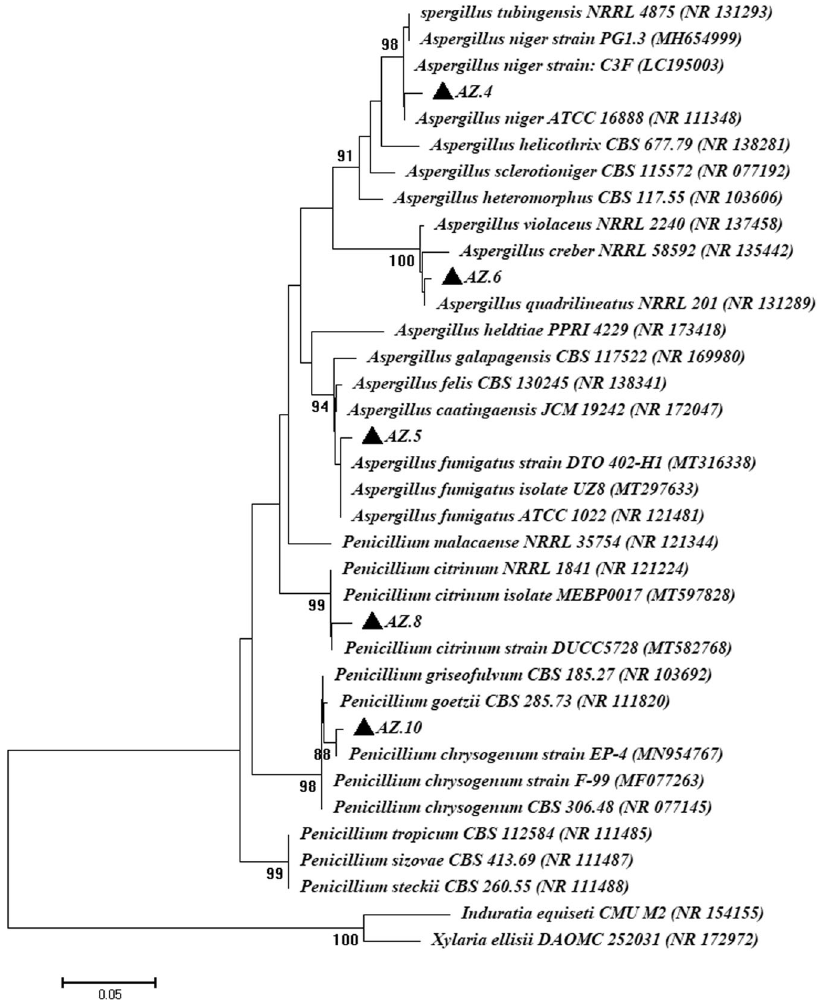
Fig. 8 Phylogenetic tree of fi ve selected fungal strains based on ITS sequences analysis compared with NCBI reference sequences. MEGA 6 was used to achieve the analysis, which used the neighbor-joining approach with a bootstrap value (1000